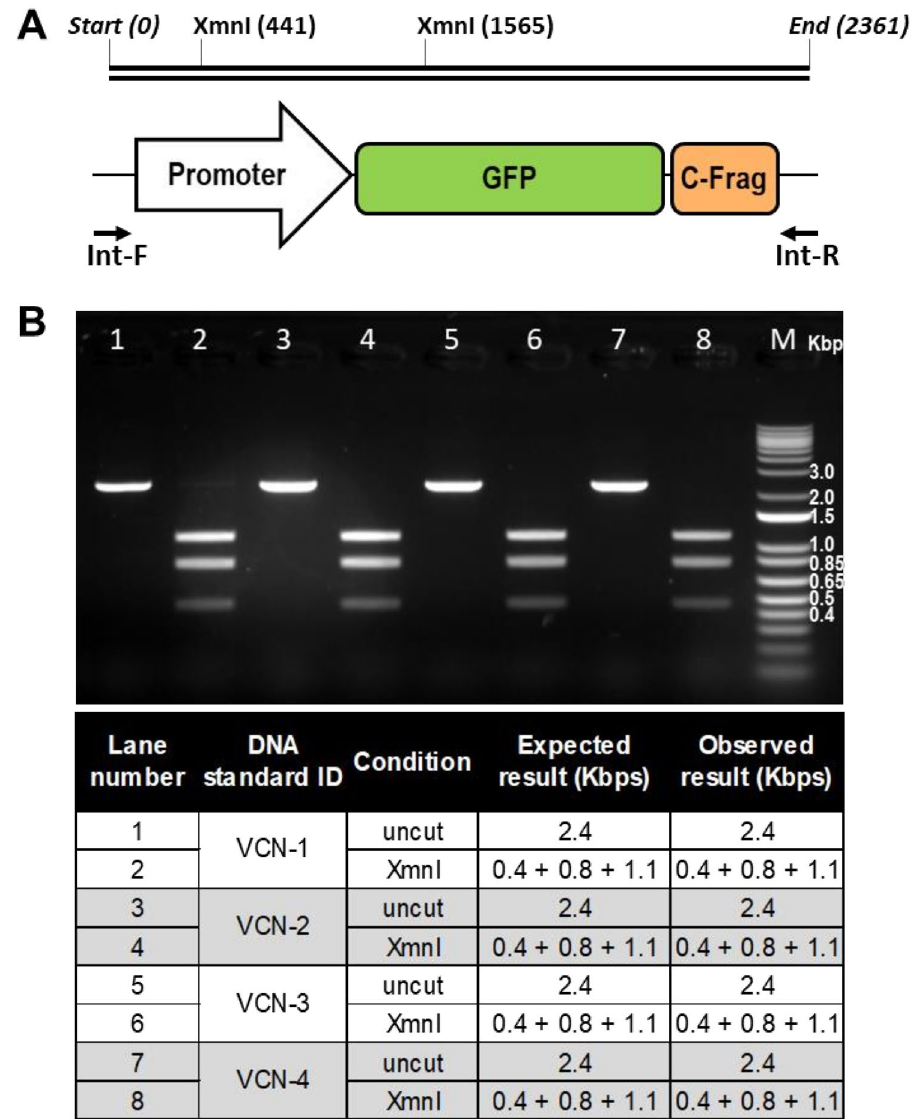
Figure 3. Genomic identity assay confirmed identity of inserted proviral sequence in established clonal cell lines. ( A ) The identity of the integrated proviral sequence was analyzed using PCR-based assay with Int-F and Int-R PCR primers flanking the sequence of a transgenic cassette including promoter sequence, open reading frame of GFP and C-Frag Id tag. ( B ) Genomic DNA extracted from each evaluated cell line was used as template material for PCR reaction and a single 2.4 Kbp amplicon was observed for each clone. Generated amplicons were purified and digested using XmnI restriction enzyme, which yields a unique three fragment pattern on the agarose